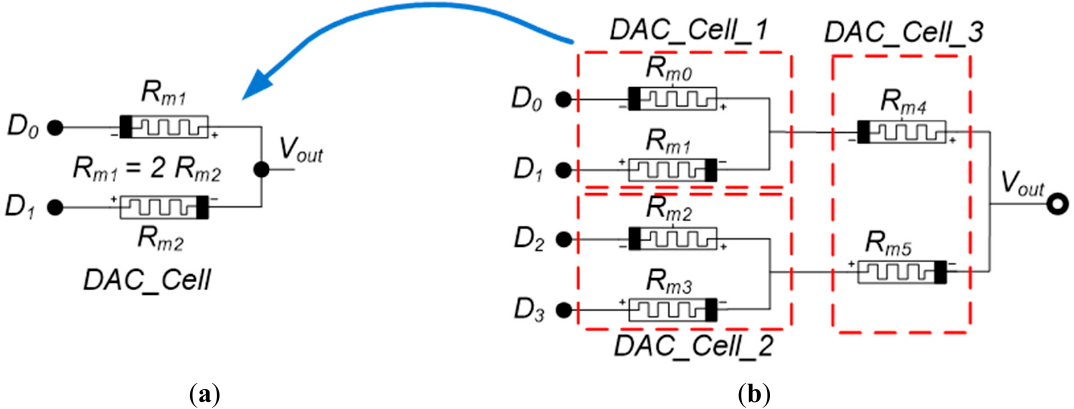
Figure 12. A binary-weighted DAC cell. ( a ) A 2 bit DAC cell circuit. ( b ) A 4 bit DAC cell circuit.